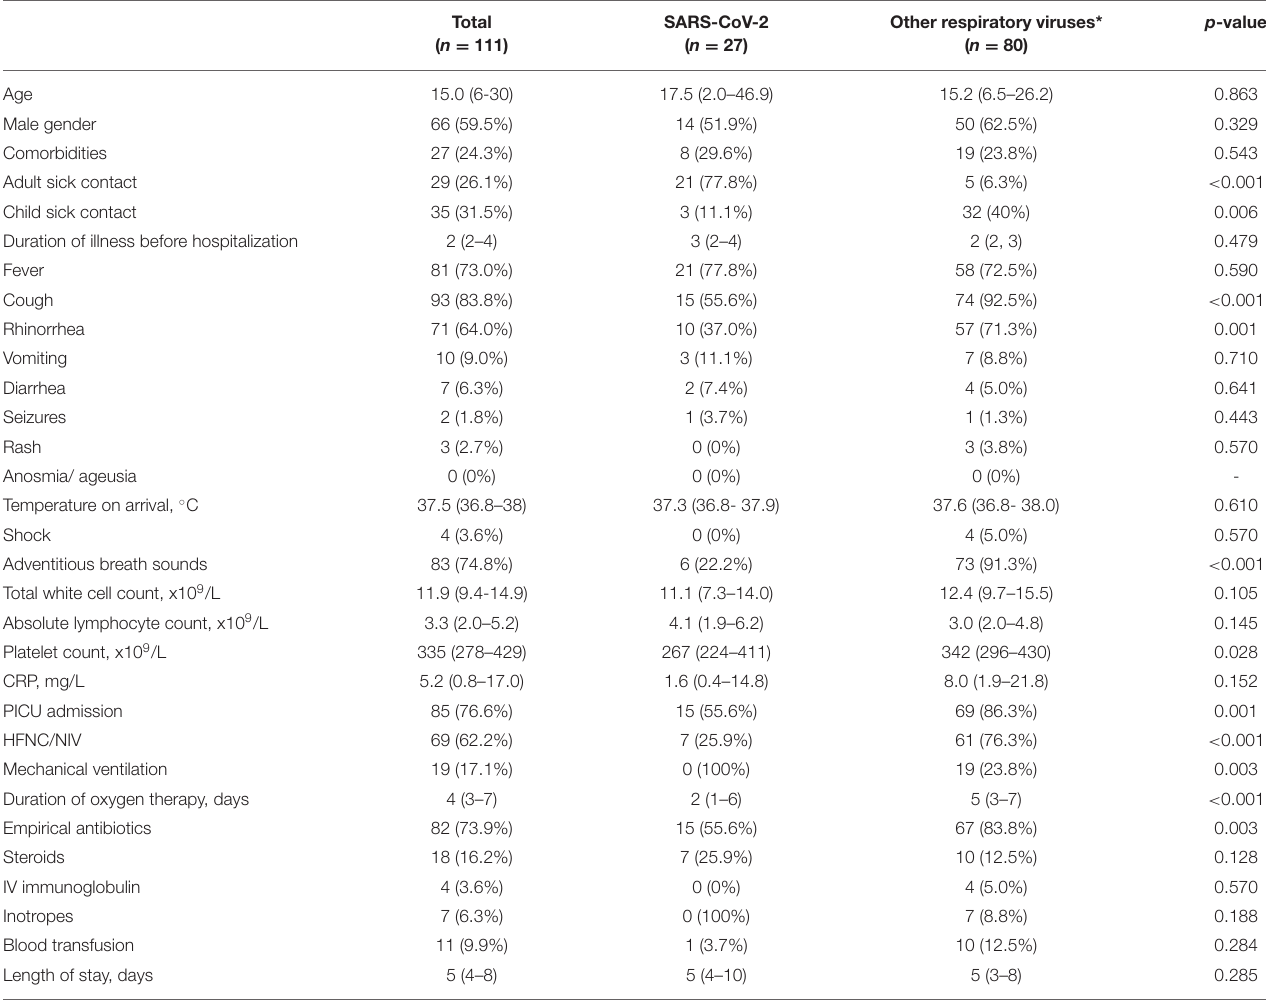
TABLE 2 | Demographics, clinical characteristics and outcomes of patients presenting with severe SARS-CoV-2 compared to other respiratory